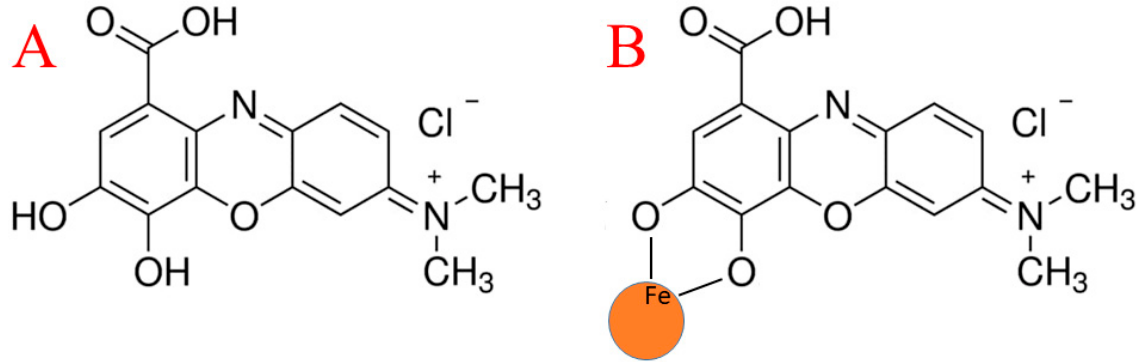
Figure 4. ( A ) Chemical structure of gallocyanine, ( B ) adsorption of gallocyanine on Fe 2 O 3 particle involving catecholate-type complexation of Fe atom on the particle surface. involving catecholate-type complexation of Fe atom on the particle